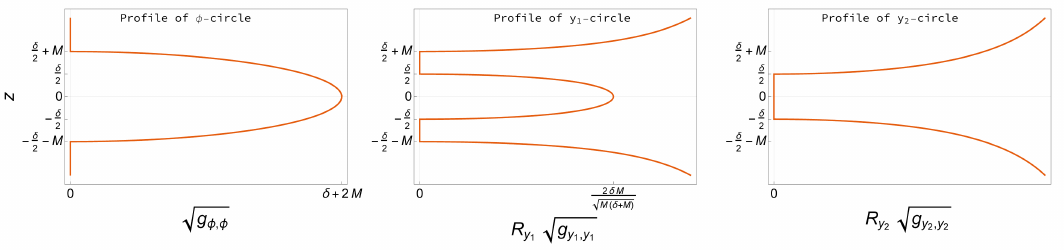
Figure 8. Sizes of the φ , y 1 and y 2 circles on the z